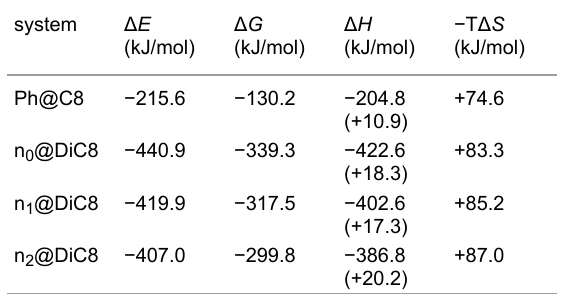
Table 2: Electronic association energy Δ E and Gibbs energy of associ- ation Δ G in the gas phase at room temperature ( T = 298.15 K).